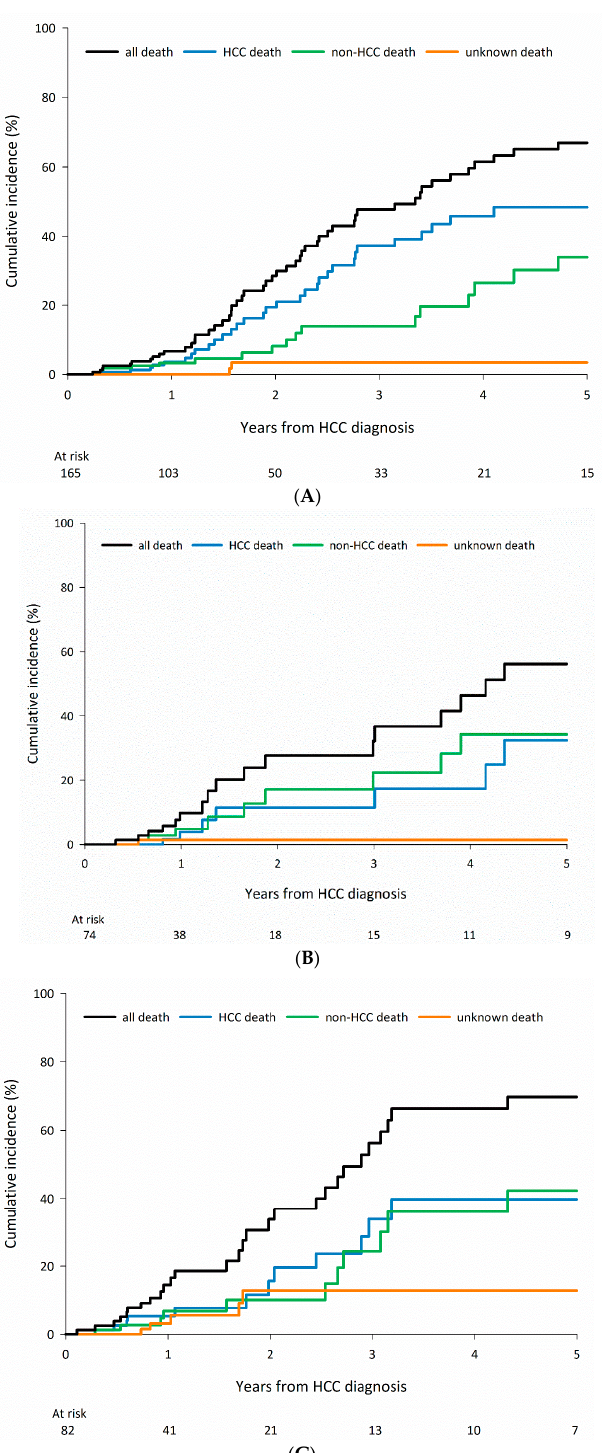
Figure 4. Cumulative mortality risk for hepatocellular carcinoma among patients 75 years and older who received curative treatments according to chronic liver disease etiology: ( A ) hepatitis C virus; ( B ) hepatitis B virus; and ( C ) all negative (defined as no evidence of virus infection or alcohol use). 3.5. Cause-Specific Mortality in Patients Who Received Non-Curative Treatments According to CLD Etiology HCC-related mortality was the leading cause of death among patients who under- went non-curative treatments, irrespective of CLD etiology (Figure 5A–D).